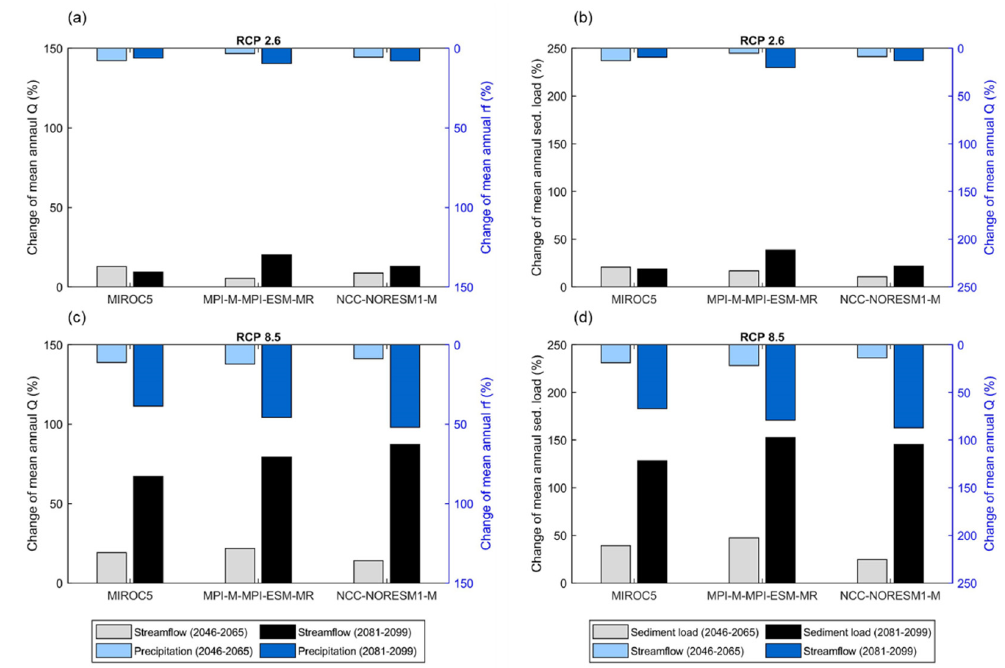
Figure 7. Percentage change in projected mean annual flow ( a , c ) and sediment load ( b , d ) at basin outlet relative to the baseline period (1991–2005) under RCP 2.6 and RCP 8.5, computed using the three RegCM4 RCM data as forcing. Q is Streamflow and rf is precipitation. Each panel (left and right) shows results for RCP 2.6 ( a , b ) and RCP 8.5 ( c , d ) and the three RegCM4 RCMs (MIROC5, MPI-M-MPI-ESM-MR, and NCC-NORESM1-M). In each subplot, the light color bar shows results for mid-century (2046–2065), whereas the dark color bar shows results for the end-century (2081–2099). In the left panel, streamflow changes are in the primary axis (left Y-axis), and precipitation changes are in the inverse secondary axis (right Y-axis). Similarly, in the right panel, sediment load changes are in the primary axis, and streamflow changes are in the inverse secondary axis.